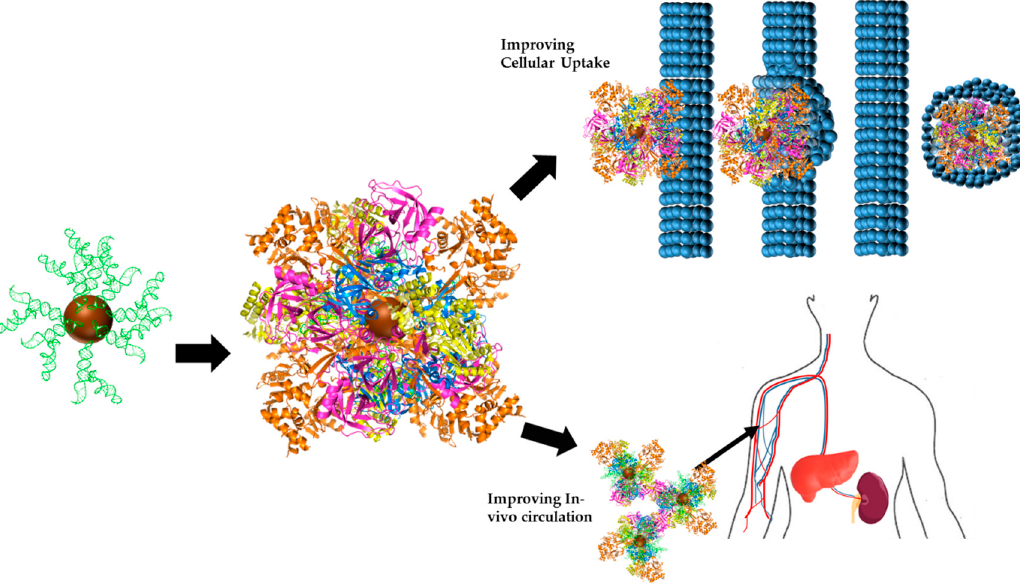
Figure 4. Protein Corona agglomeration causes changes in the identity of the RNA-NPC therapeutic. Interactions with proteins can cause masking of the RNA of interest, rendering the RNA-NPC ineffective.